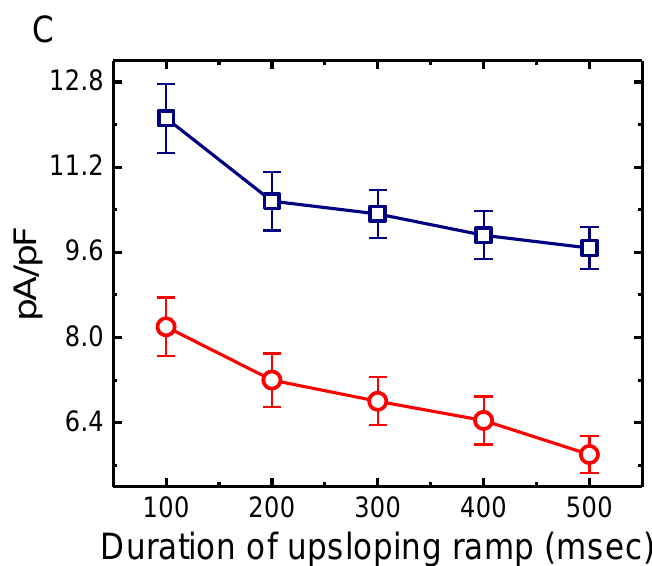
Figure 4. Effect of HNK on the deactivating I h density in response to upsloping depolarizing pulses with different durations (100–500 ms) of rising phases, which were used to mimic different rising slopes of pacemaker potential. ( A ) Representative current densities in response to the uppermost voltage protocol obtained in the absence (upper) and presence (lower) of 3 μM HNK. The uppermost part indicates the voltage profile applied. ( B ) Expanded traces of current densities obtained from the dashed box in ( A ). The asterisks shown in ( B ) indicate the hump component of I h density in response to abrupt upsloping linear pulse with different durations. ( C ) Effect of HNK on deactivating I h density (i.e., the hump component) upon return to −40 mV with different durations (mean ± SEM; n = 9 for each data point). The peak density of deactivating I h was taken at different durations of rising phase. □ : control; ○ : in the presence of 3 μM HNK.